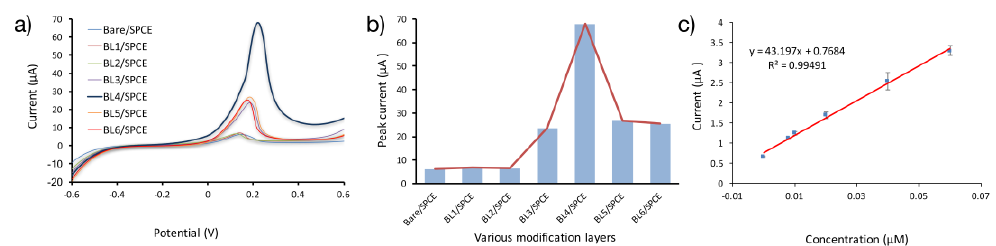
Figure 5. ( a ) Linear sweep voltammetry (LSV) voltammograms of 10 μM quinoline at bare/SPCE, BL1/SPCE, BL2/SPCE, BL5/SPCE, BL6/SPCE, BL3/SPCE, and BL4/SPCE/SPCE in 0.2 M CBS (pH 5.5) at a scan rate of 0.06 V/s ( b ) The peak current of LSV voltammograms at the surface of the electrode with various layers of modification. ( c ) Linear relationship of Oxidation peak current (Ipa) and concentrations.